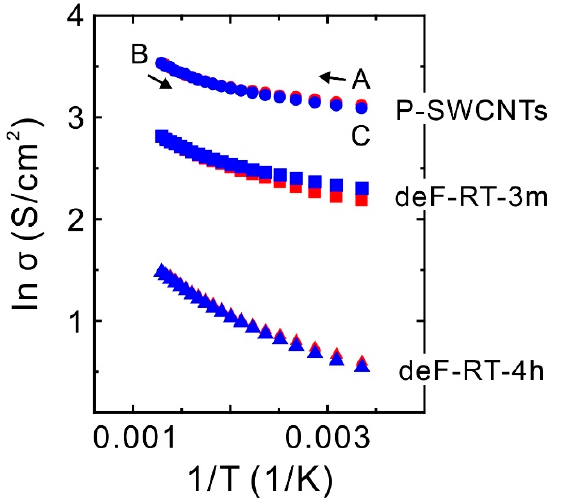
Figure 7. Electrical conductivity of the P-SWCNT, deF-RT-3m, and deF-RT-4h films as a function of temperature. Red and blue represent the conductivities from A to B and from B to C, respectively. Table 3. Conductivity of each sample at 25 ◦ C before and after the temperature rise.